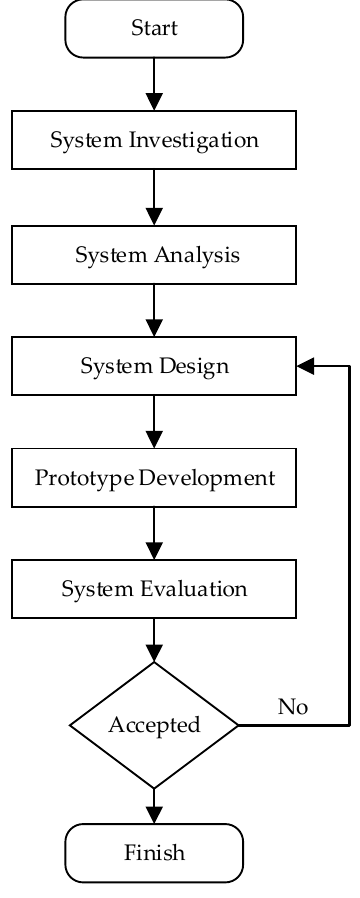
Figure 1. The method of traceability system development .